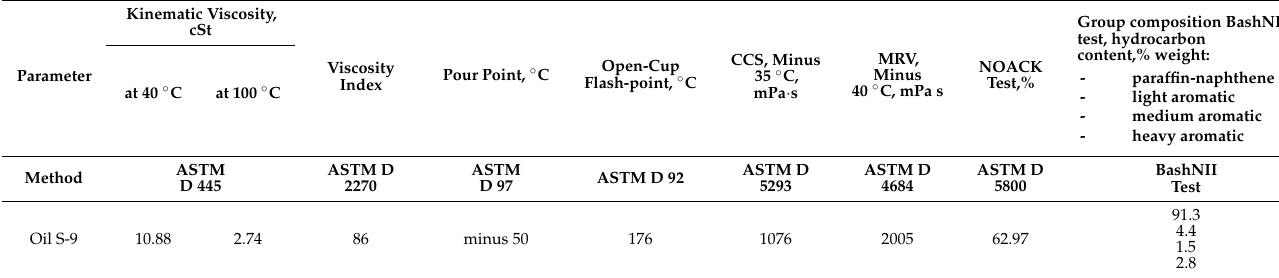
Table 2. The characteristics of the base oil